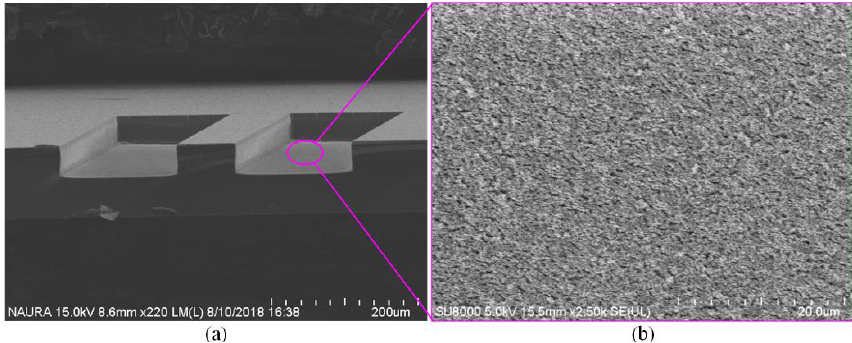
Figure 18. ( a ) The profile of etched sidewall and bottom; ( b ) the roughness of etched bottom.